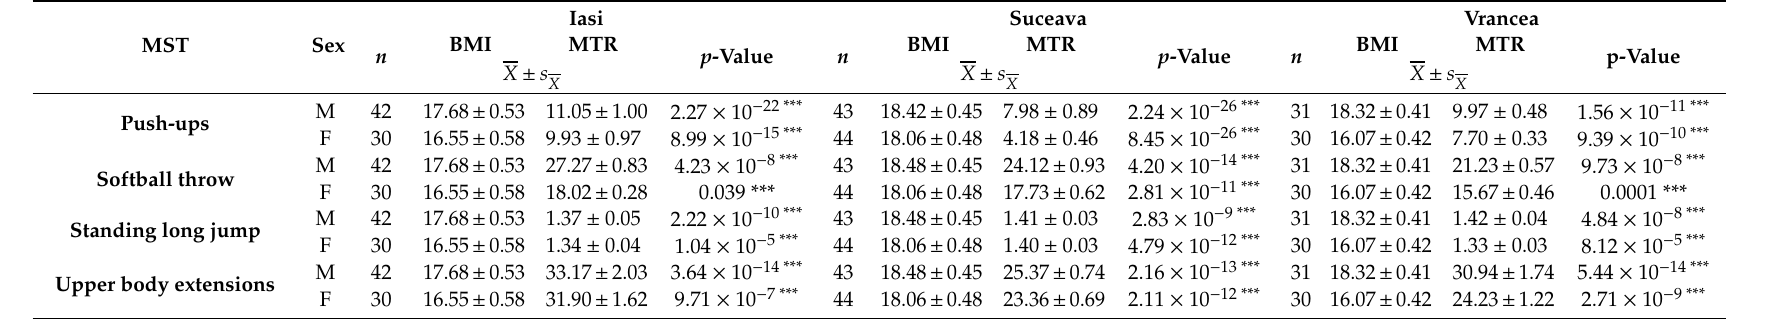
Table 5. The correlation between BMI and the motor tests applied by